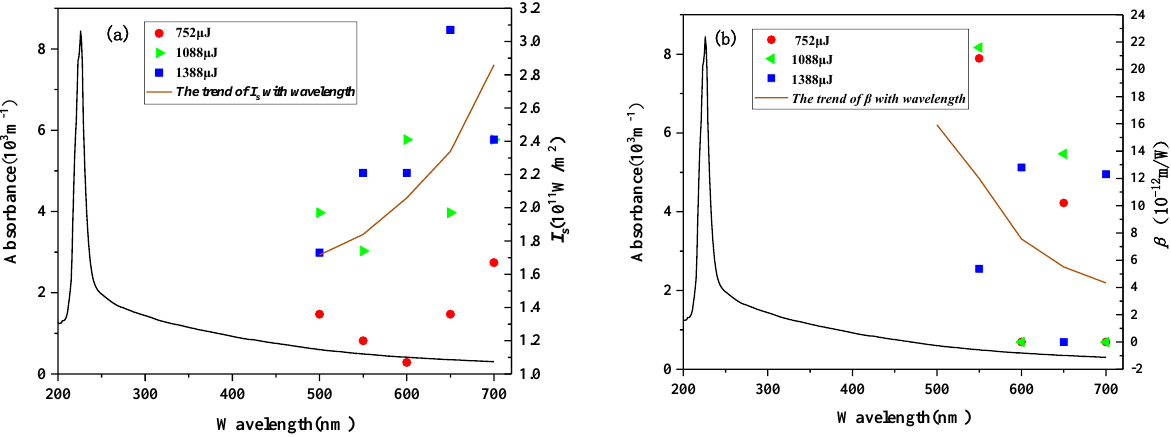
Figure 6. Nonlinear absorption characteristic curves of PtNPs depending on excitation wavelengths and the excitation energy. ( a ) The relationship curve of the saturation strength I s . ( b ) The relationship curve of the nonlinear absorption coefficient 𝛽 .